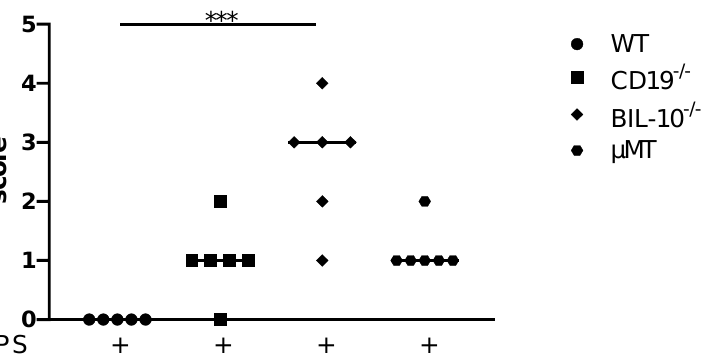
Figure 1. Scoring of maternal well-being 24 h after LPS injection at gd16. The score rating to define maternal well-being 24 h after LPS injection at gd16 was dependent on the measures and observation of mice and is shown for WT, CD19 − / − , BIL-10 − / − and µ MT mice. Data were analyzed by the Kruskal–Wallis test, followed by Dunn ´ s multiple comparisons test. N = 5–6 mice/group; *** p < 0.001.